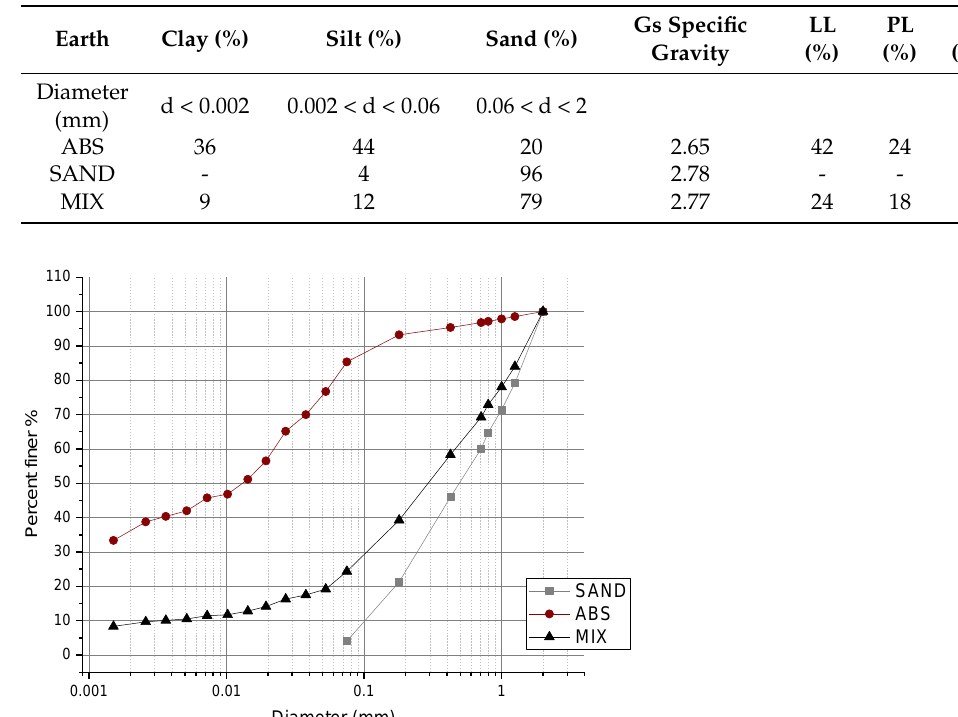
Table 1. Grain size distribution, specific gravity and Atterberg limits of soil (ABS), SAND, and MIX (1:3 soil-to-sand ratio). Liquid limit (LL), plastic limit (PL) and plasticity index (PI) are also reported [20]. Copyright 2021 Scientific.Net.